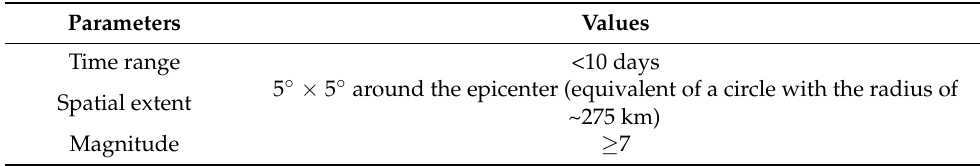
Table 1. Fundamental forecasting parameters of pre-seismic anomalies in retrospective analyses according to the trend characteristics of multiparametric TIA.